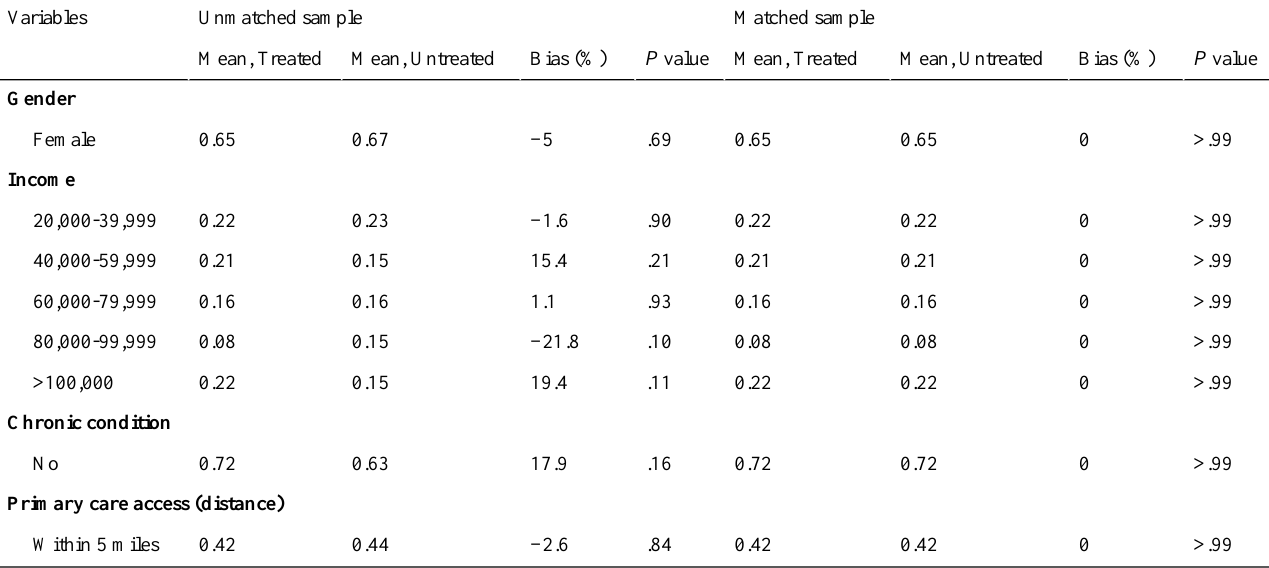
Table 3. Covariate balance before and after propensity score matching.